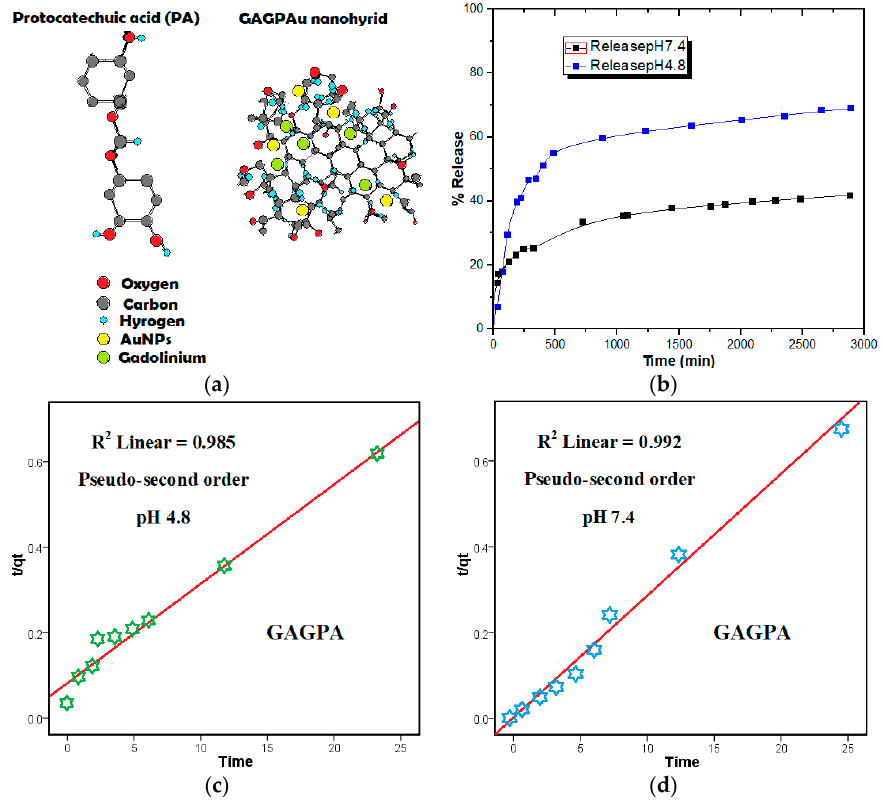
Figure 1. ( a ) Active agents-loaded of GAGPAu nanocomposite in a theranostic nanodelivery system. Diagnostic agents, gadolinium (green) and AuNPs (yellow) and the anticancer agent, PA are attached on a graphene sheet via hydrogen bond, π – π interaction and electrostatic interaction (GOTS); ( b ) Release profiles of protocatechuic acid from GO-Gd/PA nanocomposite (GAGPA) in pH 7.4 and 4.8 media; ( c ) Pseudo − seconder order kinetic plot of protocatechuic acid release data at pH 4.8 medium from GAGPA nanocomposite (Drug-GO/Gd); ( d ) Pseudo − seconder order kinetic plot of protocatechuic acid release data at pH 7.4 medium from GAGPA nanocomposite (Drug-GO/Gd).